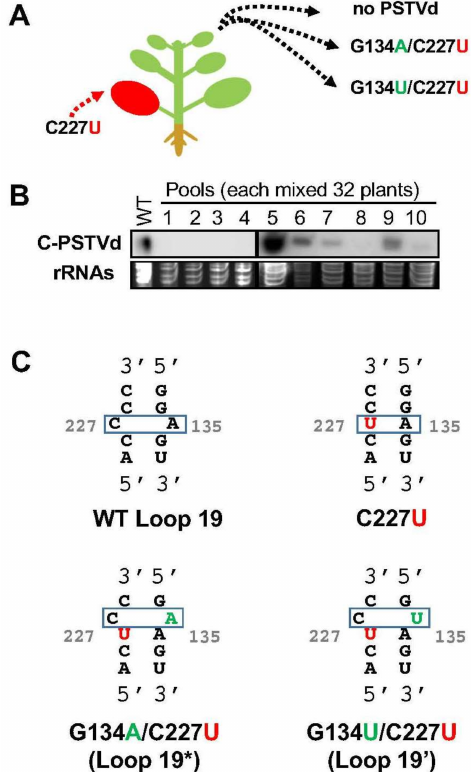
Figure 3. Rapid emergence of functional RNA motifs. ( A ) Inoculation of PSTVd IntC227U mutant led to the emergence of new variants in progeny, which showed up in systemic leaves; ( B ) Northern blots showed the presence of PSTVd in pooled samples from systemic leaves. C-PSTVd, circular PSTVd. rRNAs served as the loading control; and ( C ) illustrations of loop 19* and loop 19 (cid:48) . The U at the 227 position in the mutant background is highlighted in red, and the newly-emerged substitutions of A or U at 134 position are highlighted in